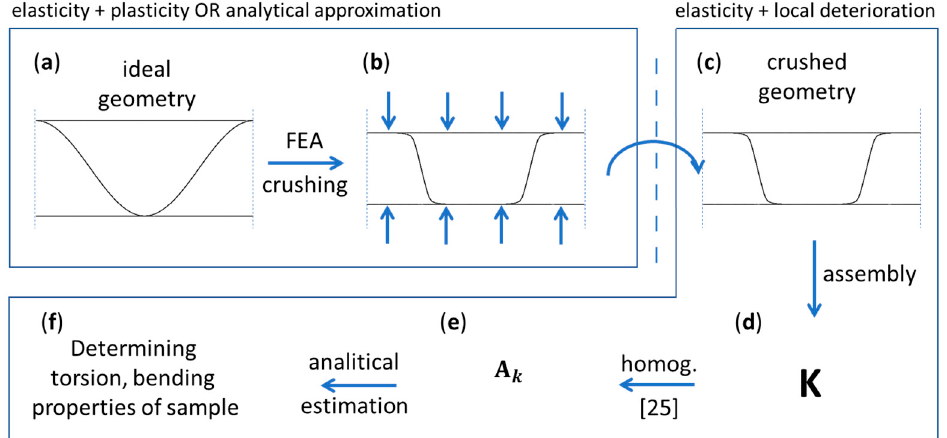
Figure 6. The scheme representing the steps of numerical study conducted in this study: ( a ) unde ‐ formed RVE, ( b ) loaded and deformed RVE, ( c ) crushed geometry extracted, ( d ) material stiffness matrix of RVE, ( e ) the representative shell stiffness matrix and ( f ) tests outcomes from analytical estimation.